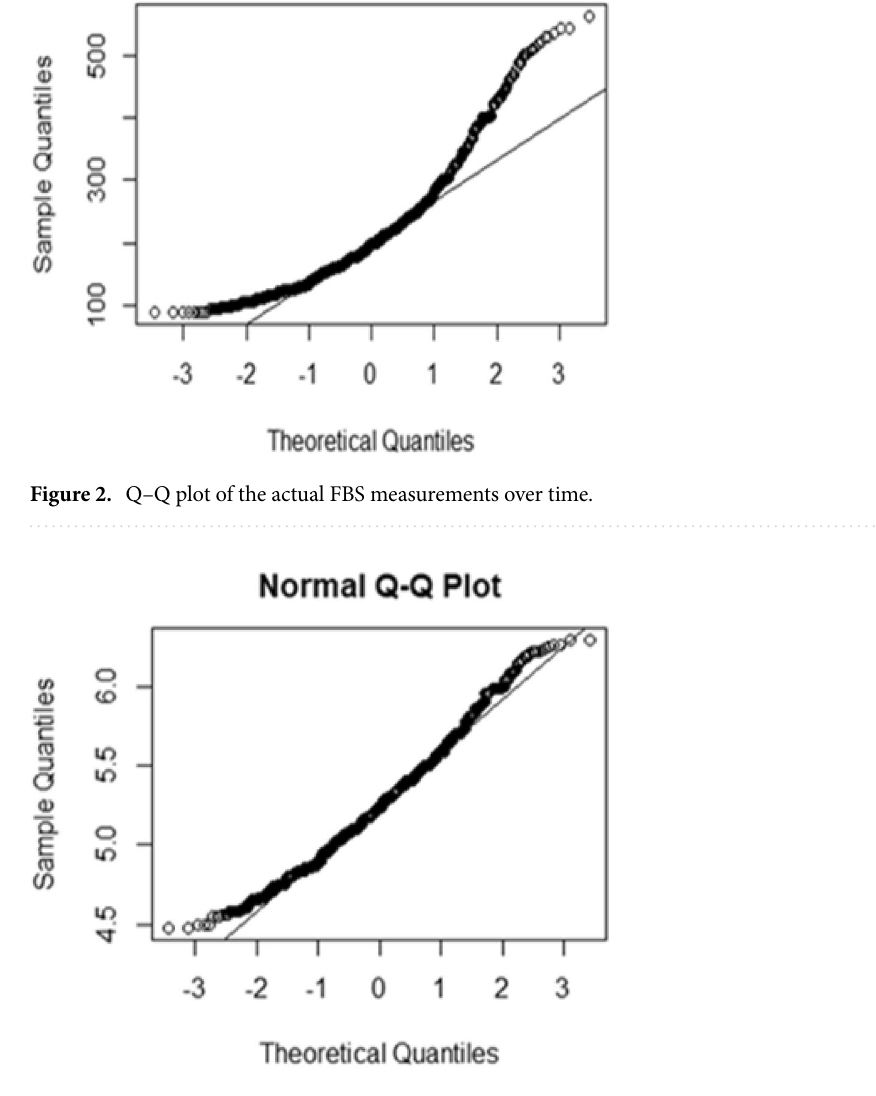
Figure 3. Q–Q plot of the lnFBS measurements over